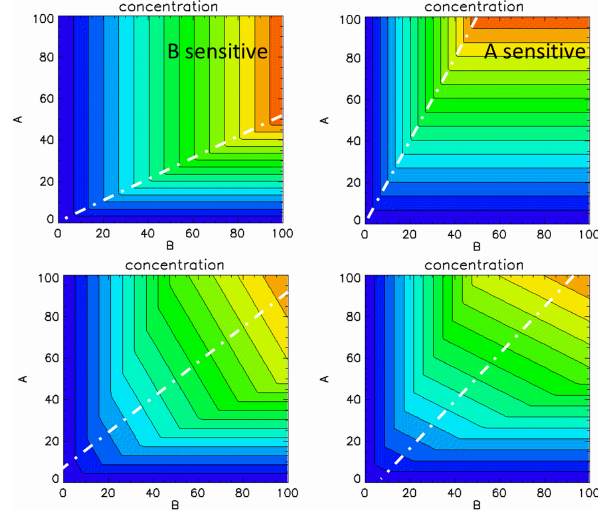
Figure B1. Isopleths for a simple theoretical system consisting of two emission precursors (A and B) competing through non-linear reactions to the concentration of a pollutant. See details in the